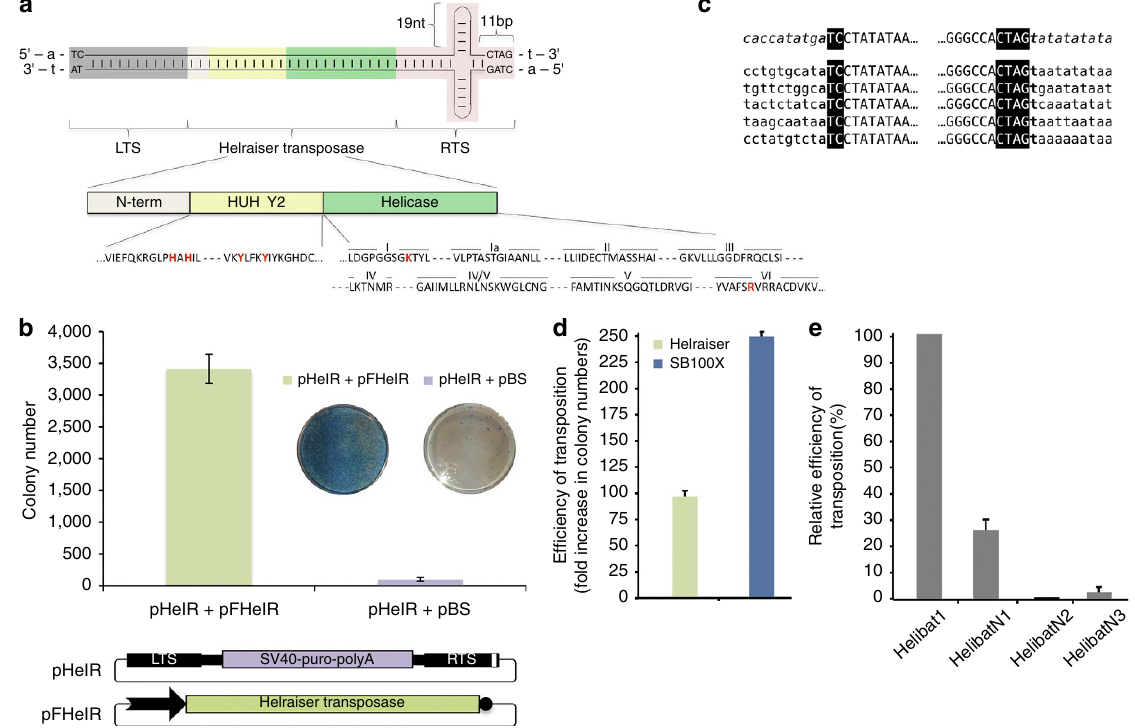
Figure 1 | Features of Helraiser transposition in human HeLa cells. ( a ) Schematic representation of the Helraiser transposon. LTS and RTS terminal sequences are in uppercase, and flanking A and T host target site sequences are in lowercase. White, yellow and green rectangles represent N-terminal, endonuclease and helicase domains of the Helraiser transposase, respectively. Conserved amino-acid motifs are shown below. Positions of the residues used for mutagenesis are shown in red. ( b ) Helraiser colony-forming efficiency. Shown are tissue culture plates containing stained puro-resistant HeLa cell colonies. Helraiser donor (pHelR) and helper (pFHelR) plasmids. White rectangle in RTS: hairpin; black arrow: promoter driving transposase expression, black circle: polyA signal; these annotations are used consistently in all the figures. Data are represented as mean ± s.e.m., n ¼ 7 biological replicates. ( c ) Helraiser transposition generates canonical insertions. Helraiser LTS- or RTS-to-genome juctions are shown for 10 independent transposon